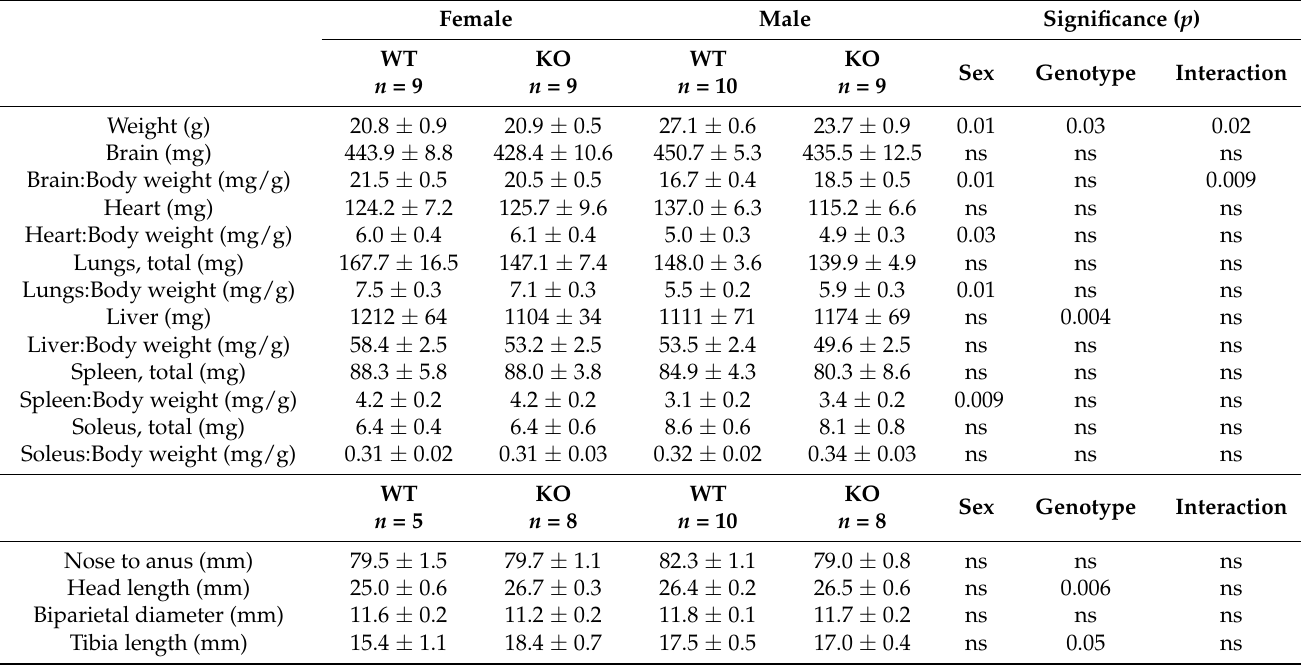
(9.7 ± 0.3 and 9.9 ± 0.3 weeks, respectively). Data are mean ± SEM. Statistical differences are indicated: main effect of sex, main effect of genotype, and sex × genotype interaction (two-way ANOVA with Tukey’s post-hoc comparison).